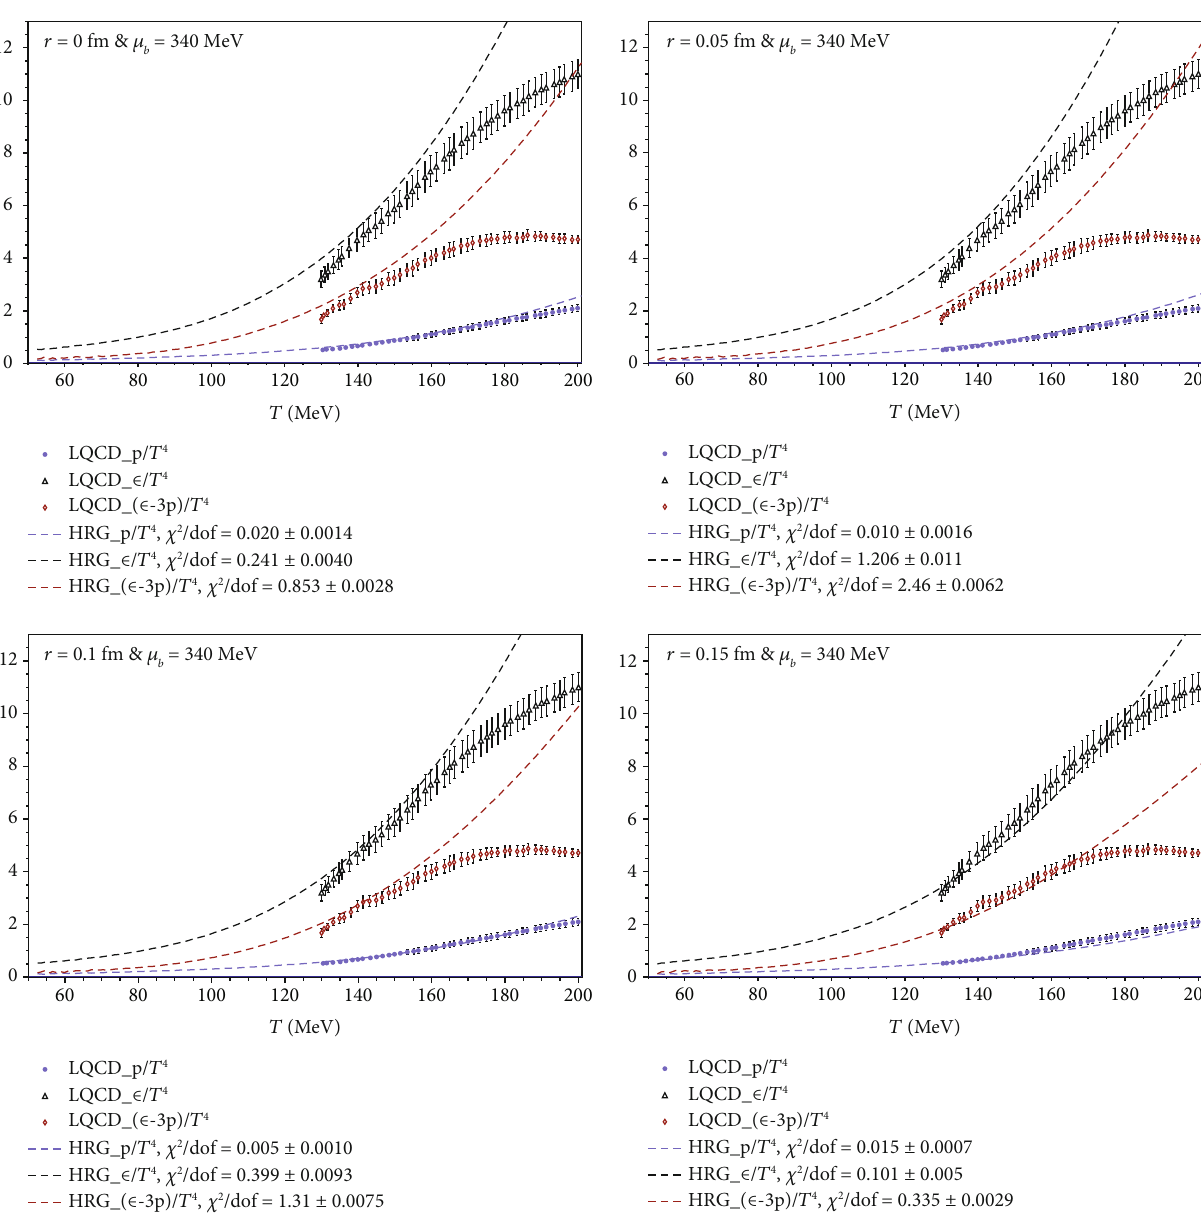
Figure 3: The same as in Figure 1 but at μ